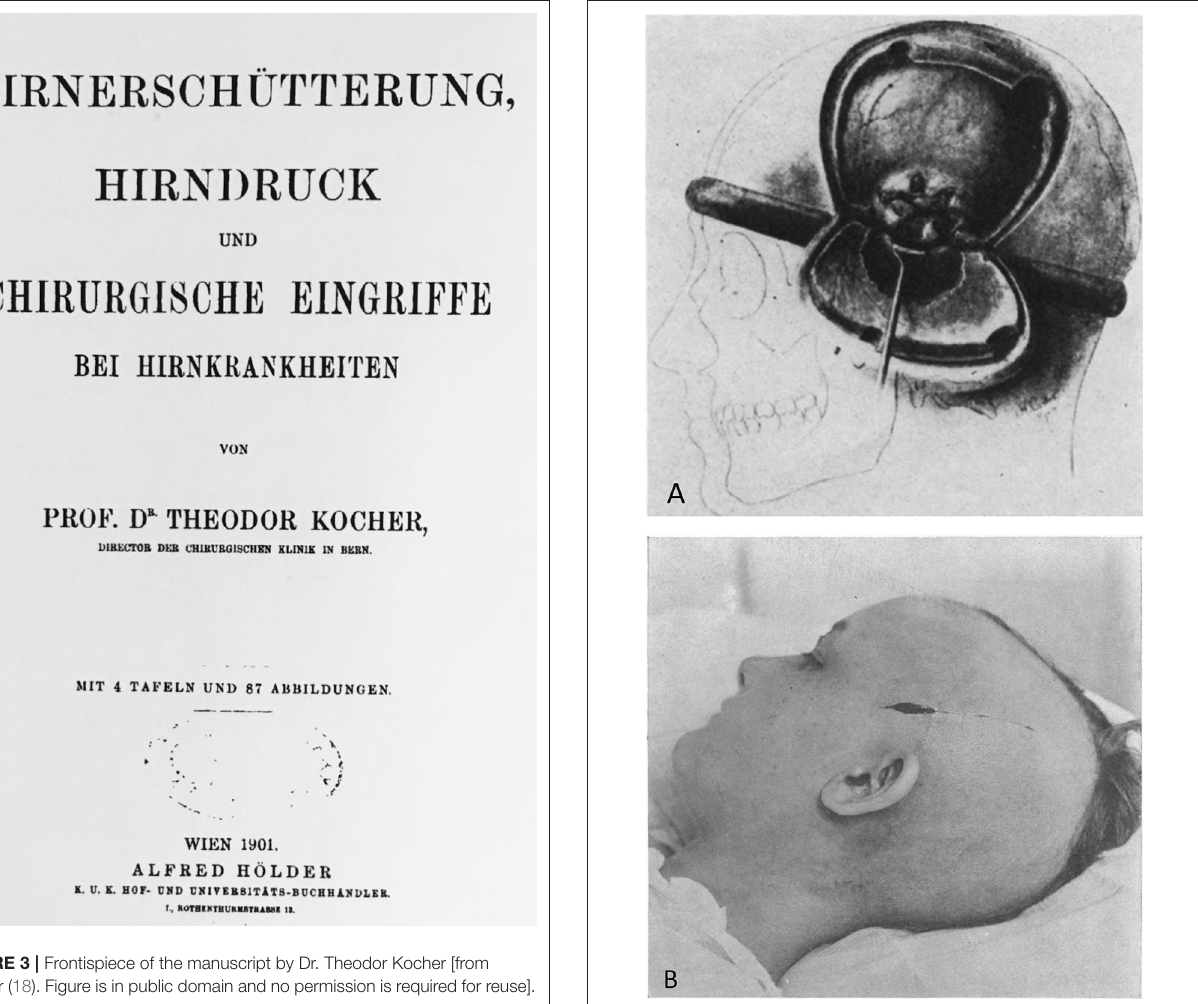
FIGURE 4 | (A) Decompressive measures described by Cushing for the management of cerebral hernia in inaccessible brain tumors [from Cushing (21). Figure is in public domain and no permission is required for reuse]. (B) Incision of the scalp for subtemporal craniectomy [from Cushing (20). Figure is in public domain and no permission is required for